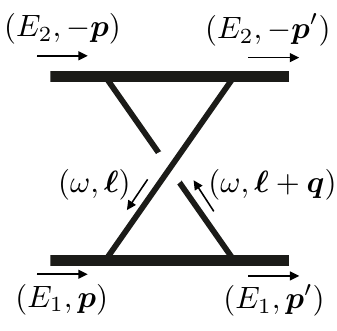
Figure 17 . The crossed-box